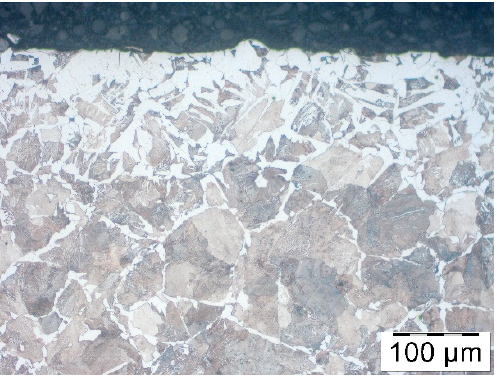
Figure 9. Microstructure in the top layer of the forged part after hot forging and cooling—with no lubrication.